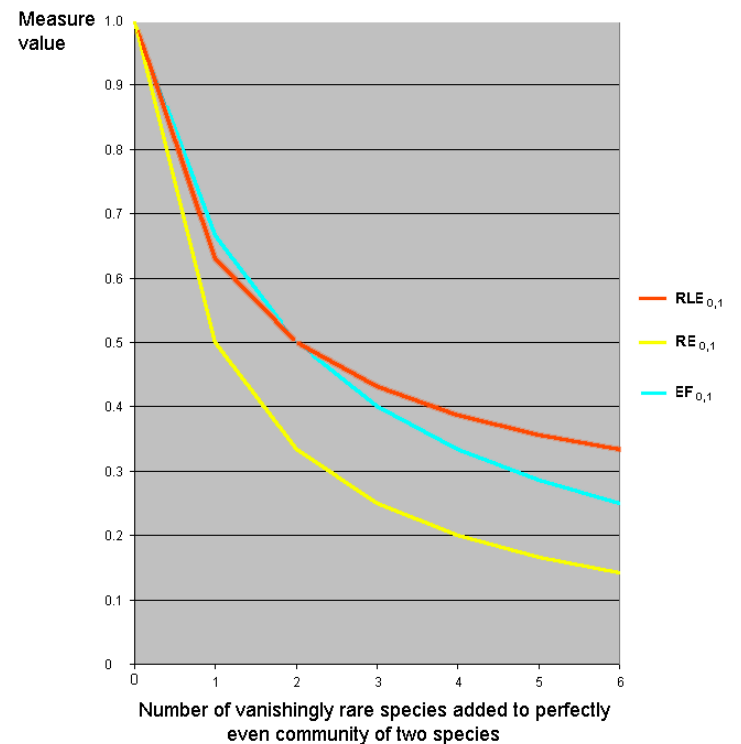
Figure 6. Sensitivity of evenness measures to ultra-rare species for a variety of